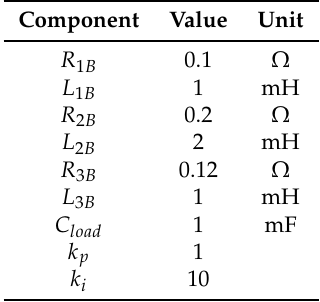
Table 4. Patrol base microgrid parameter